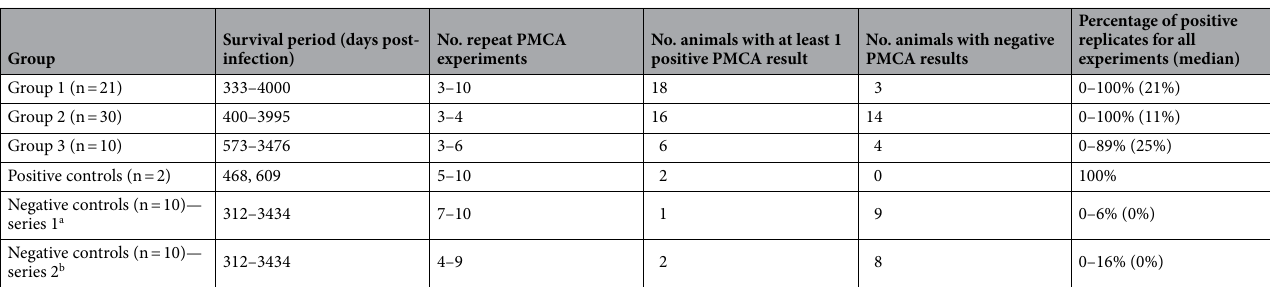
Table 1. Summary of PMCA test results on prescapular lymph node samples from “pathology negative” sheep. a Series 1—negative controls run in experiments with test samples for Groups 1 and 3. b Series 2—negative controls run in experiments with test samples for Group